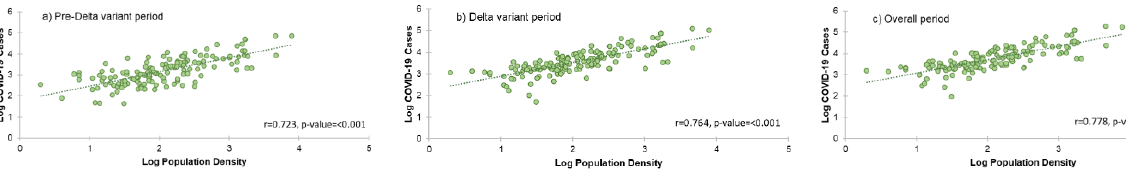
Figure 4. Correlation between population density and COVID-19 cases, ( a ) Pre-Delta variant period, ( b ) Delta variant period, ( c ) Overall period. Table 2. Correlation analysis in relation to Delta variant during the third wave in Malaysia, 20